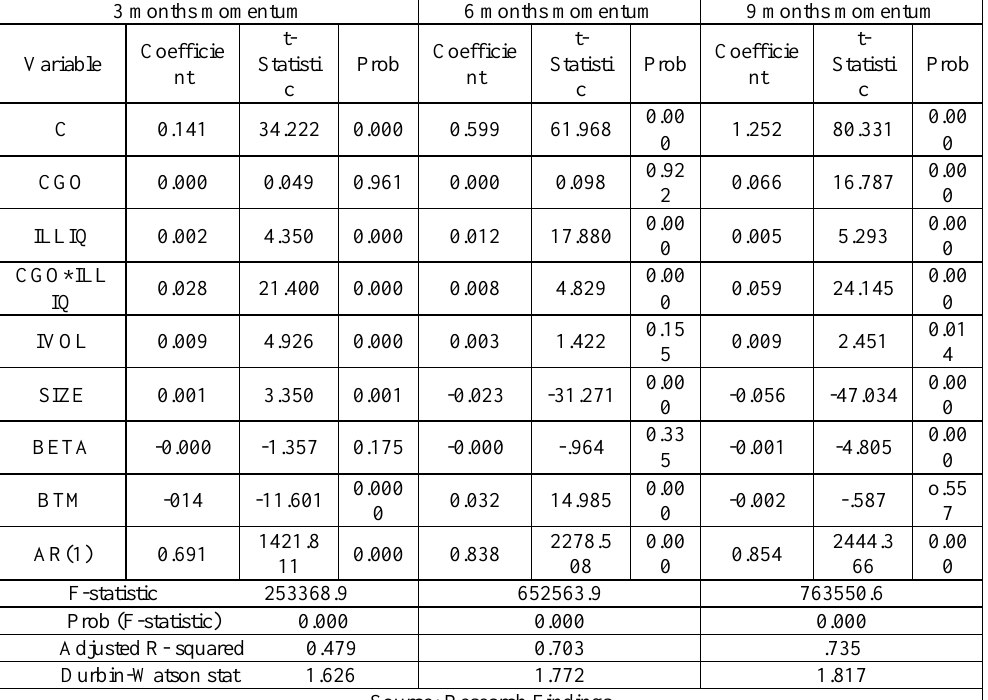
Table 2. Regression results for the disposition effect in stocks with low liquidity